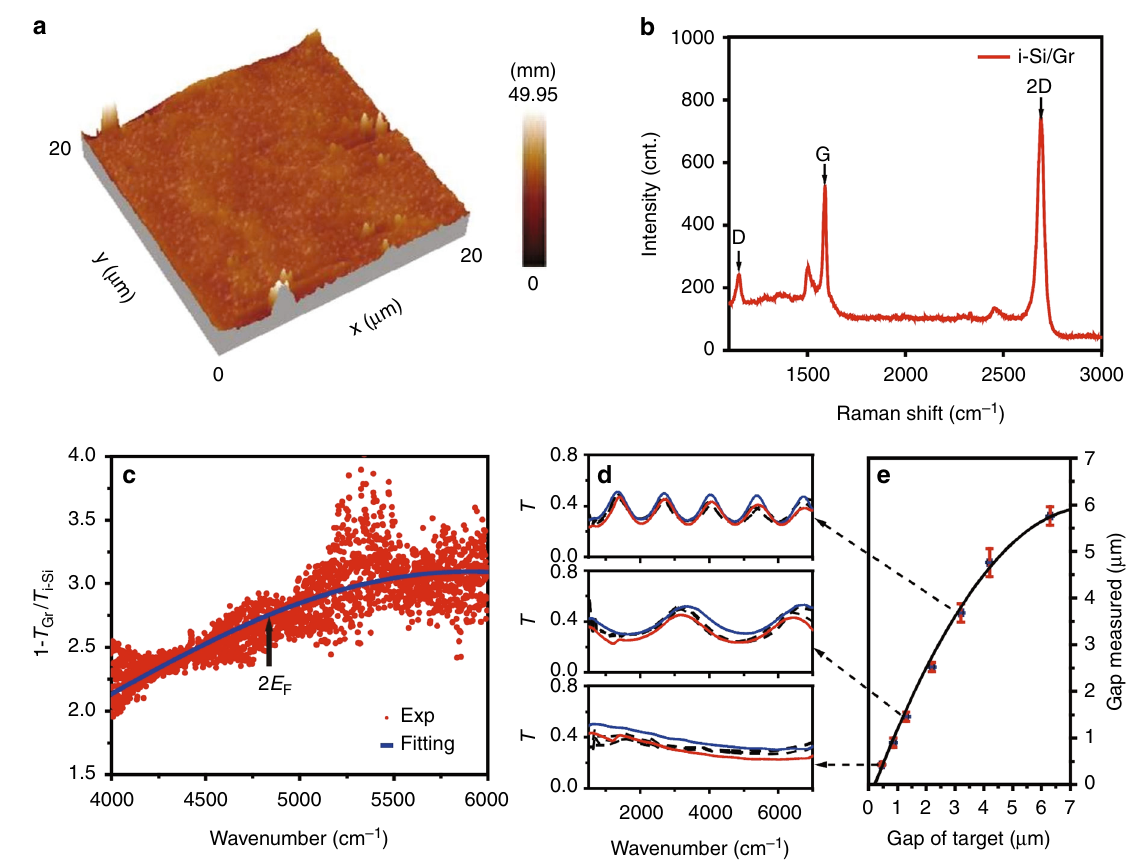
Fig. 2 Characterization of i-Si/Gr properties. a A typical 3D AFM picture of the i-Si/Gr sample. The largest roughness of the sample is about 50 nm. b The Raman spectrum of the i-Si/Gr sample. The monolayer feature of graphene is identi fi ed by the strong 2D resonance peak. c The absorption spectrum of graphene on intrinsic silicon. The red dots are measured results by FTIR and the blue line is a Gaussian function fi tting. T Gr and T Si denote the transmittance with and without the graphene cover, respectively. The “ 2 E F onset ” of the inter-band transition is estimated at about 4832.8 cm − 1 , corresponding a Fermi level at E F = 0.27 eV. d Measured (dashed lines) and calculated (solid lines) FTIR spectra at three different target gap sizes of 3.7, 1.4, and 0.43 μ m. The uncertainty of gap size is considered here so that the calculated lines (red and blue) could cover the experimental curves measured at various spatial points. The statistic value for the smallest gap we designed is about 430 ± 25 nm. e Correspondence between the measured and the target gap sizes. The gap uncertainty is shown by the error bar derived from the measurements at multiple points. The black curve is a guidance line for eye, which shows nearly a linear relationship when the gap value is within few micron meters. Figure 2 by Yang J et